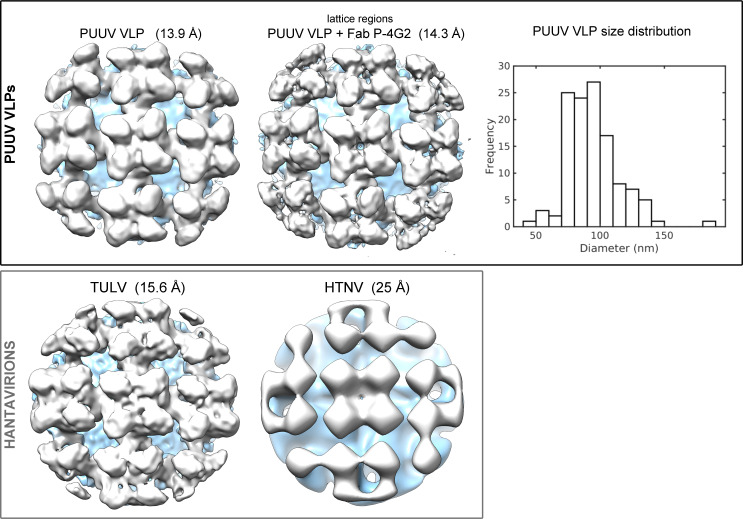
The Puumala virus (PUUV) virus-like particle (VLP) surface displays ordered regions of glycoprotein lattice and is congruent with previously published reconstructions.Size-distribution plot of the VLPs (upper right corner) shows that the pleomorphic particles vary in size, with most particles measuring between 80 and 100 nm in the longest dimension. Despite the variable resolutions of the present reconstructions of hantaviral surfaces, the tetragonal lattice organization observed in PUUV VLP (13.9 Å) and in PUUV VLP treated with P-4G2 (14.3 Å) is similar to that of Tula virus (TULV, 15.6 Å, EMDB-4867) (Li et al., 2016) and Hantaan virus (HTNV, 25 Å, EMDB-2056) (Battisti et al., 2011). A top view of each viral surface reconstruction is shown, and densities corresponding to viral membrane and envelope glycoproteins are rendered in light blue and shades of gray and white, respectively.